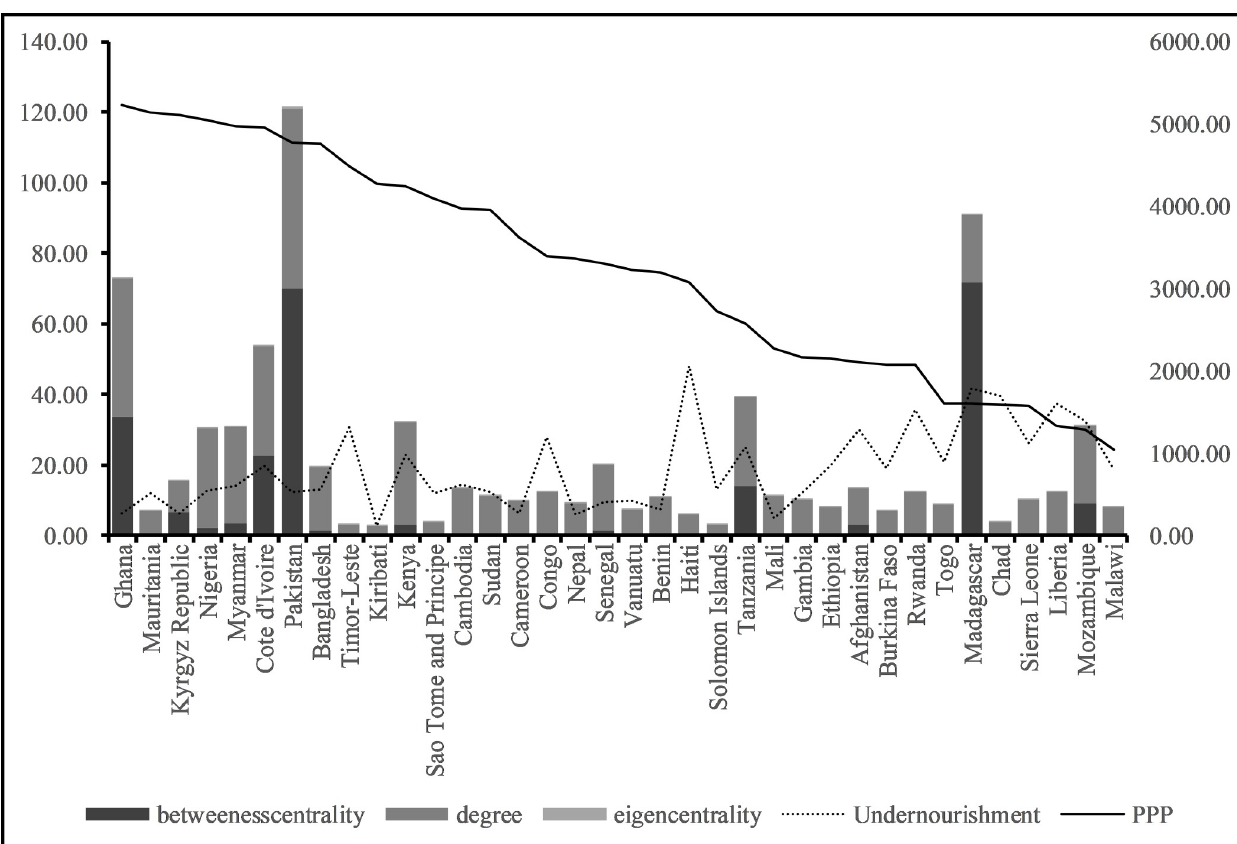
Fig 6. Countries with low purchasing power, undernourishment and their centrality